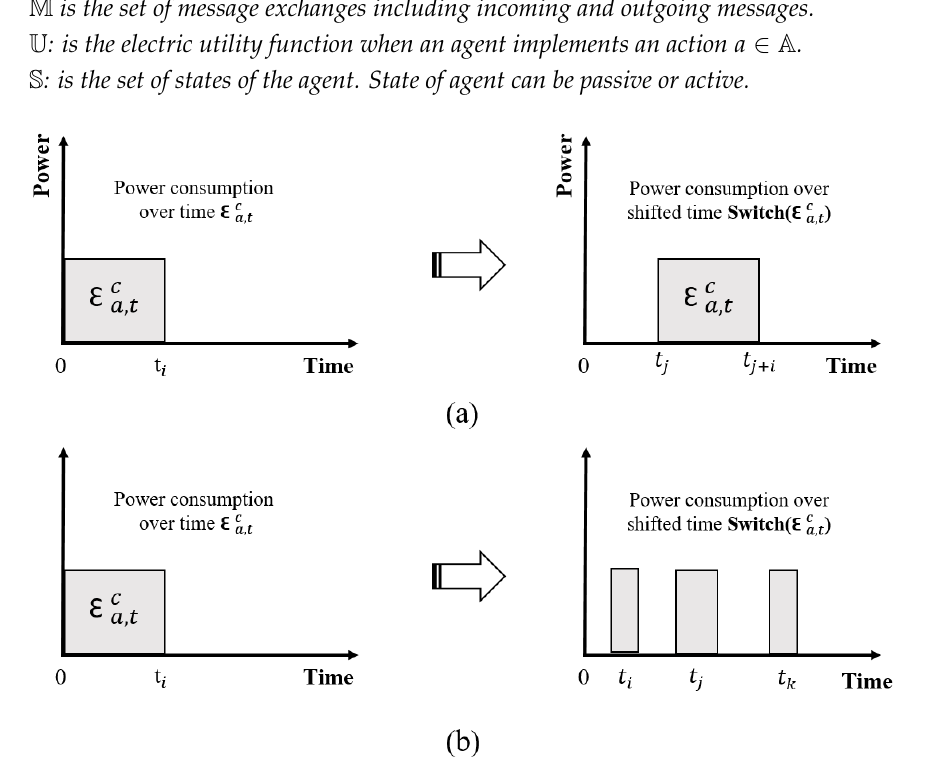
Figure 5. ( a ) generic load shift model; ( b ) flexible load shift